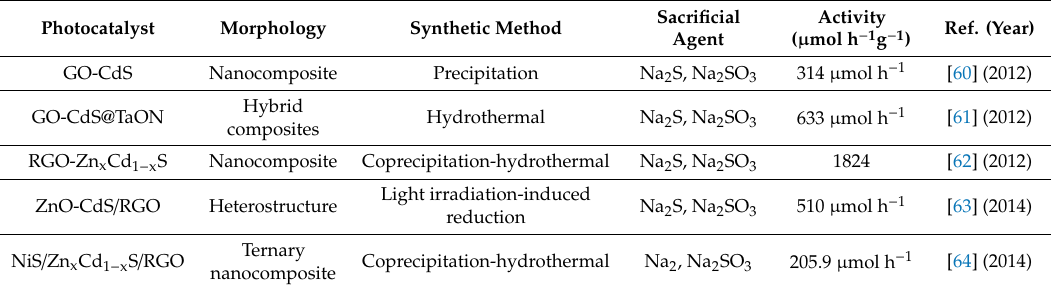
Table 6. Photocatalytic H 2 production for graphene oxide loaded with composite photocatalysts.